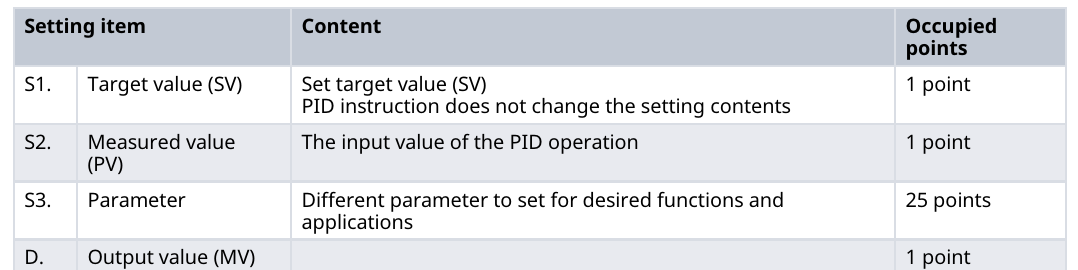
Table 6. PID block